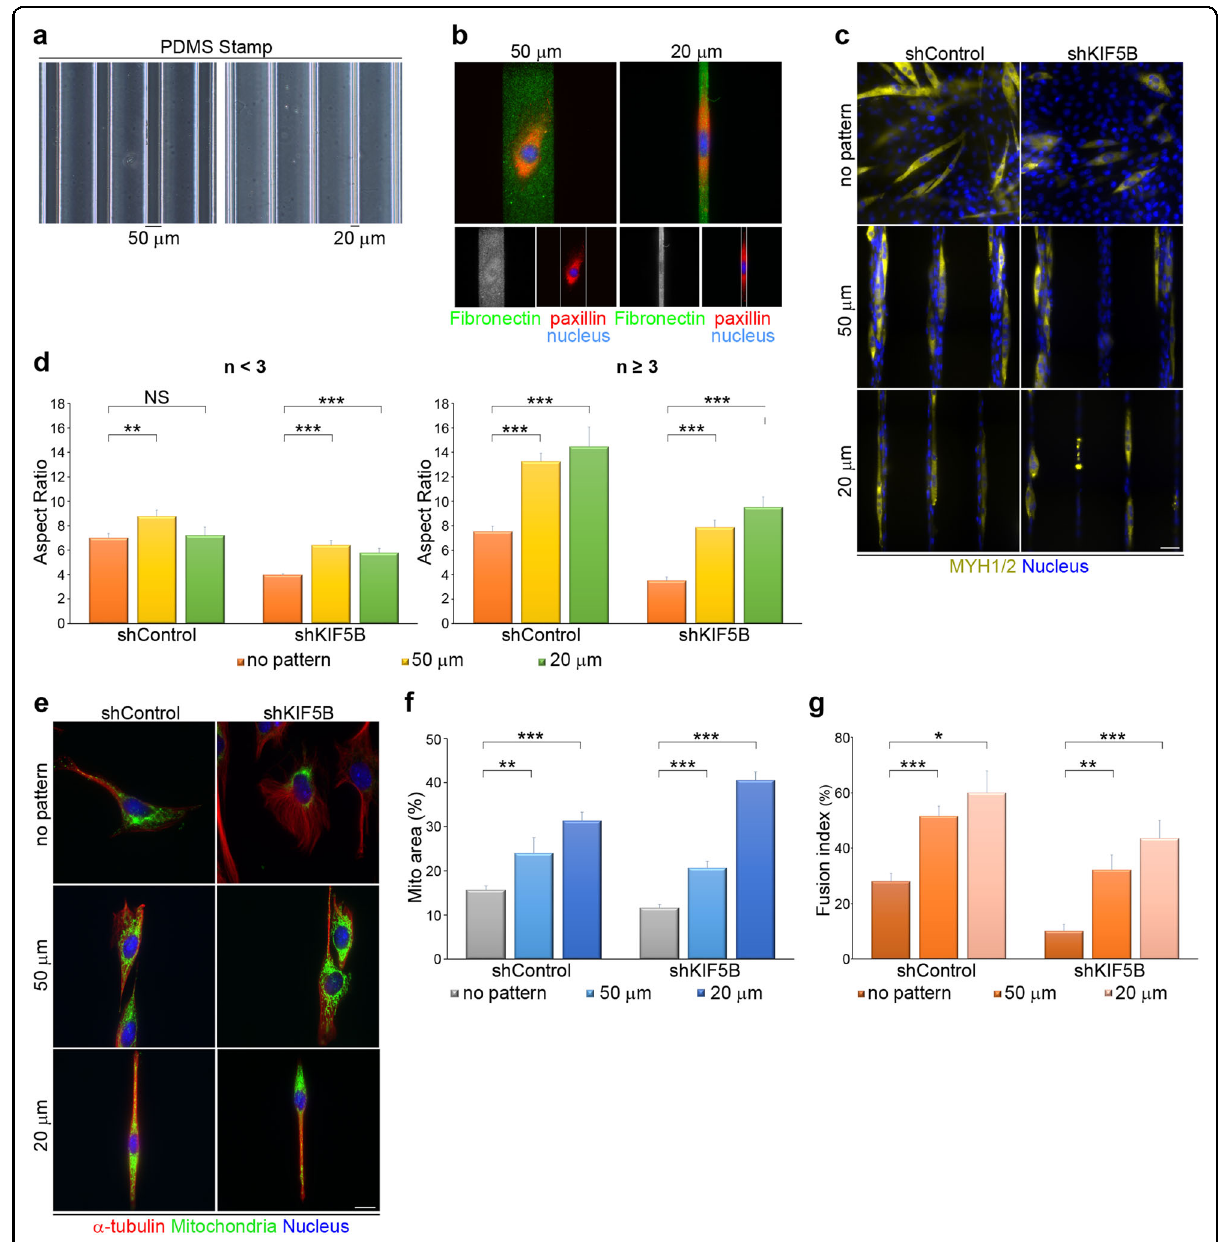
Fig. 5 (See legend on next